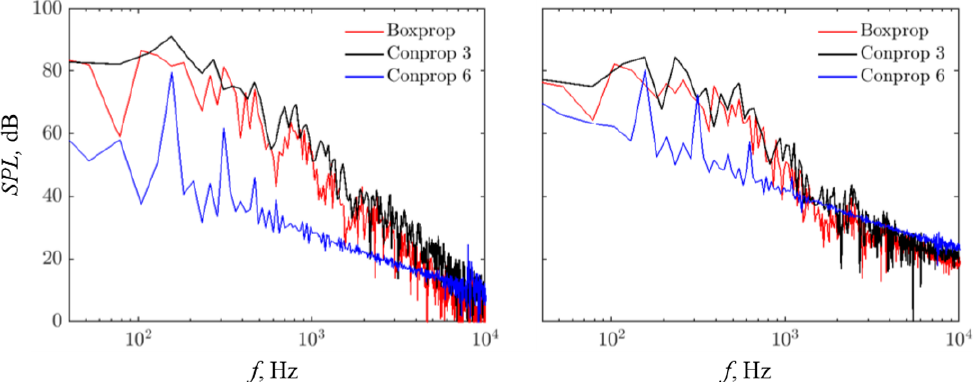
Figure 16. The SPL spectra of the noise from the blade-tip vortices, compared at the far-field microphone positions located at θ = 60 ◦ ( left ) and 90 ◦ ( right